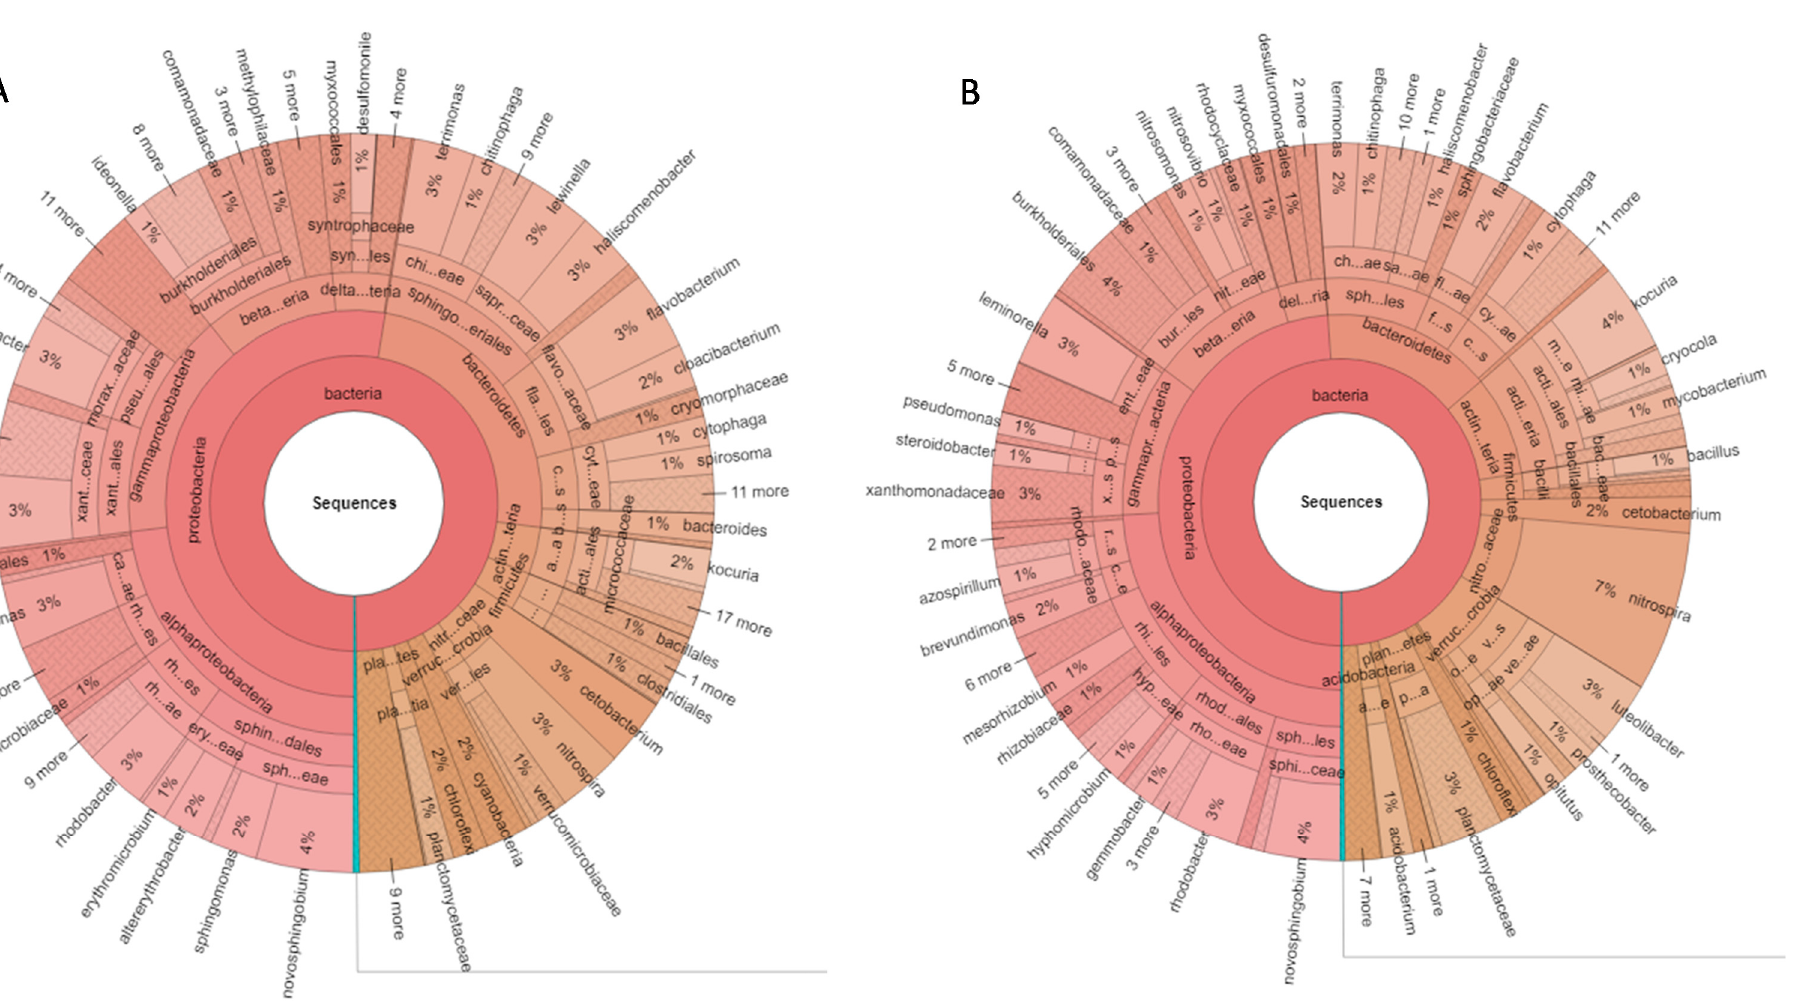
Figure 1. Hierarchical distribution and relative abundance of prokaryote genera presented in the ( A ) fish tank ( n = 3) and ( B ) plant compartment ( n = 3) based on sequencing of V4 16S rRNA gene diversity analysis.